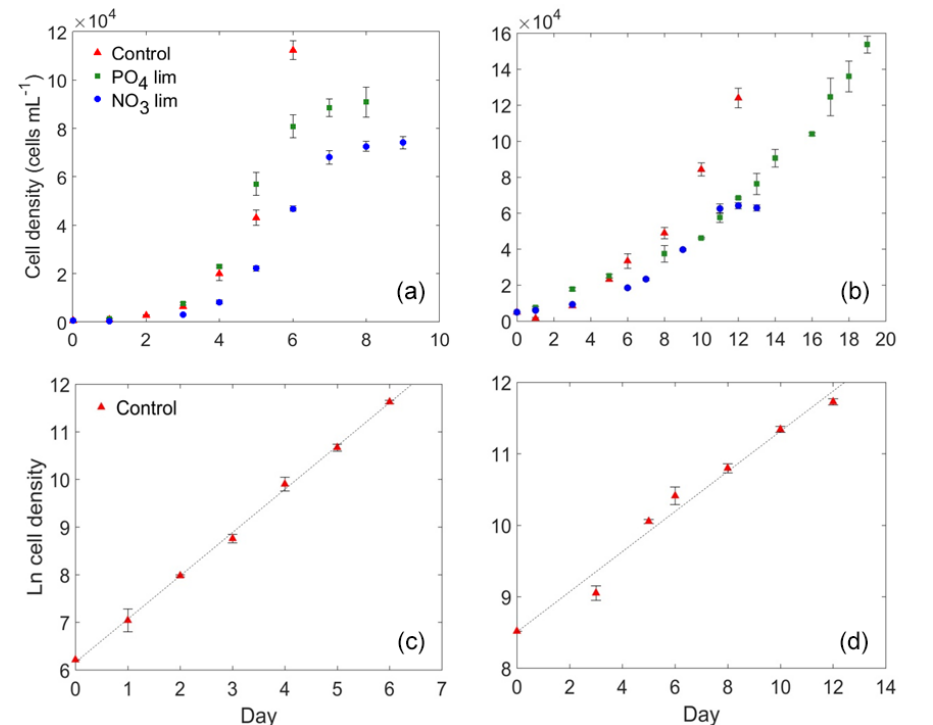
Figure 1. The evolution of cell density with time in culture experiments with E. huxleyi strain RCC911 in (a) high irradiance, (b) low irradiance and cell density on a logarithmic scale for nutrient-replete cultures in (c) high irradiance and (d) low